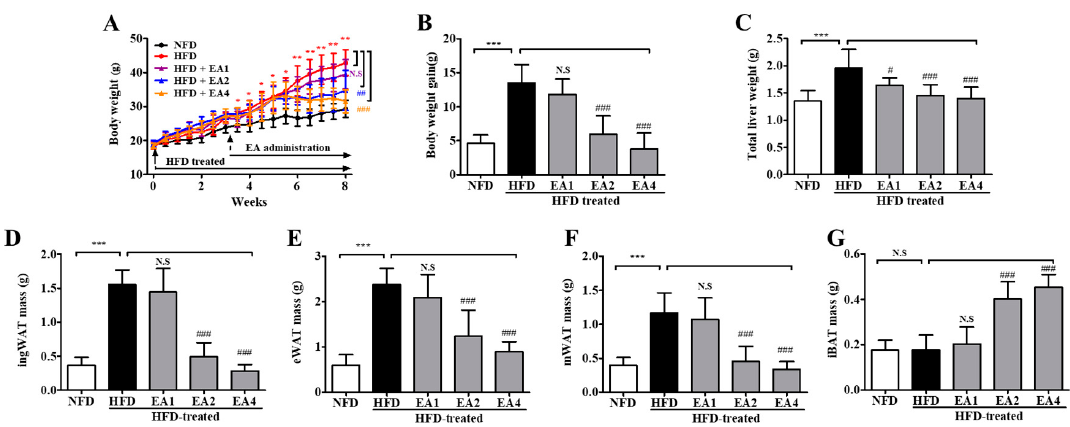
Figure 5. Ellagic acid ameliorates obesity in HFD-fed mice. ( A ) Time course of body weights during the 8-week feeding period. ( B ) Gained body weight, ( C ) total liver weight, ( D ) inguinal white adipose tissue weight, ( E ) epididymal white adipose tissue weight, ( F ) mesenteric white adipose tissue weight, and ( G ) interscapular brown adipose tissue weight. The results are presented as the mean ± SD (n = 8). * p < 0.05, ** p < 0.01 and *** p < 0.001 vs. NFD group; # p < 0.05, ## p < 0.01 and ### p < 0.001 vs. HFD group. N.S., not significant.